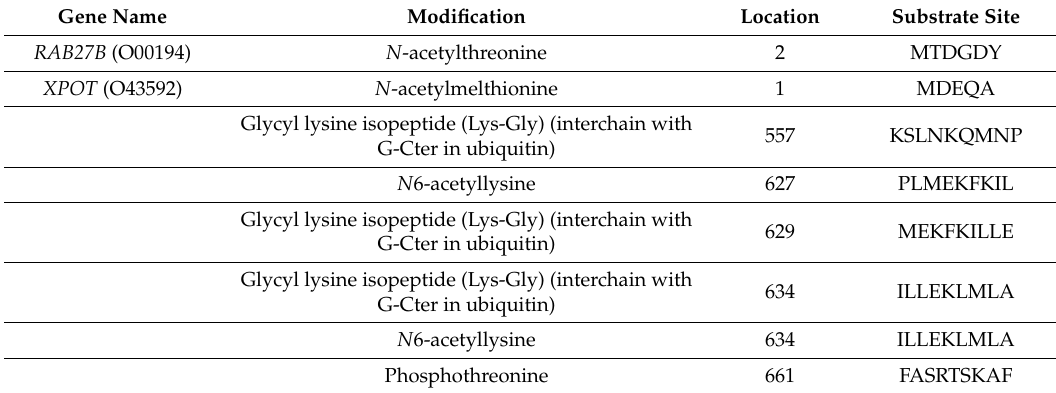
Table 2. Five exemplary proteins and their PTMs with location and short sequences before and after a modified site.